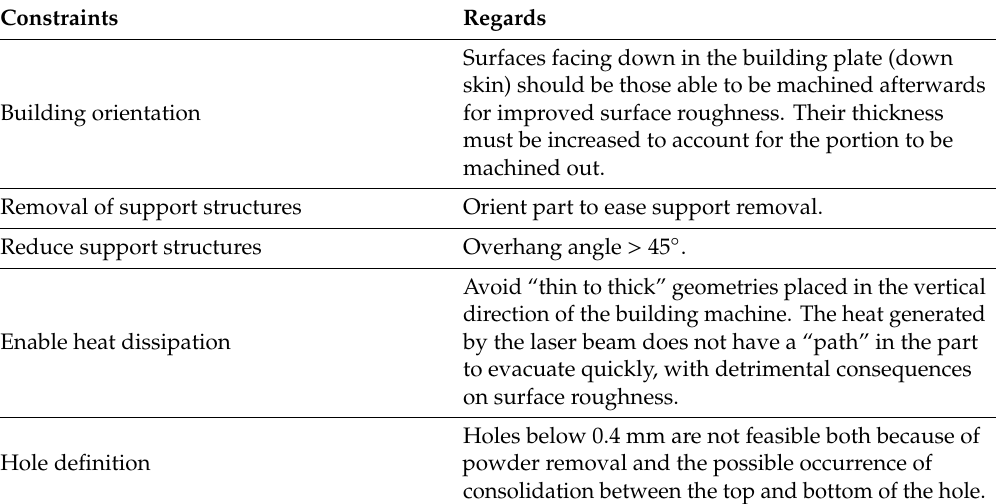
Table 2. The Additive Manufacturing (AM) laser powder-bed fusion (LPBF) constraints relevant for the manufacturing process of the propellant flow connector